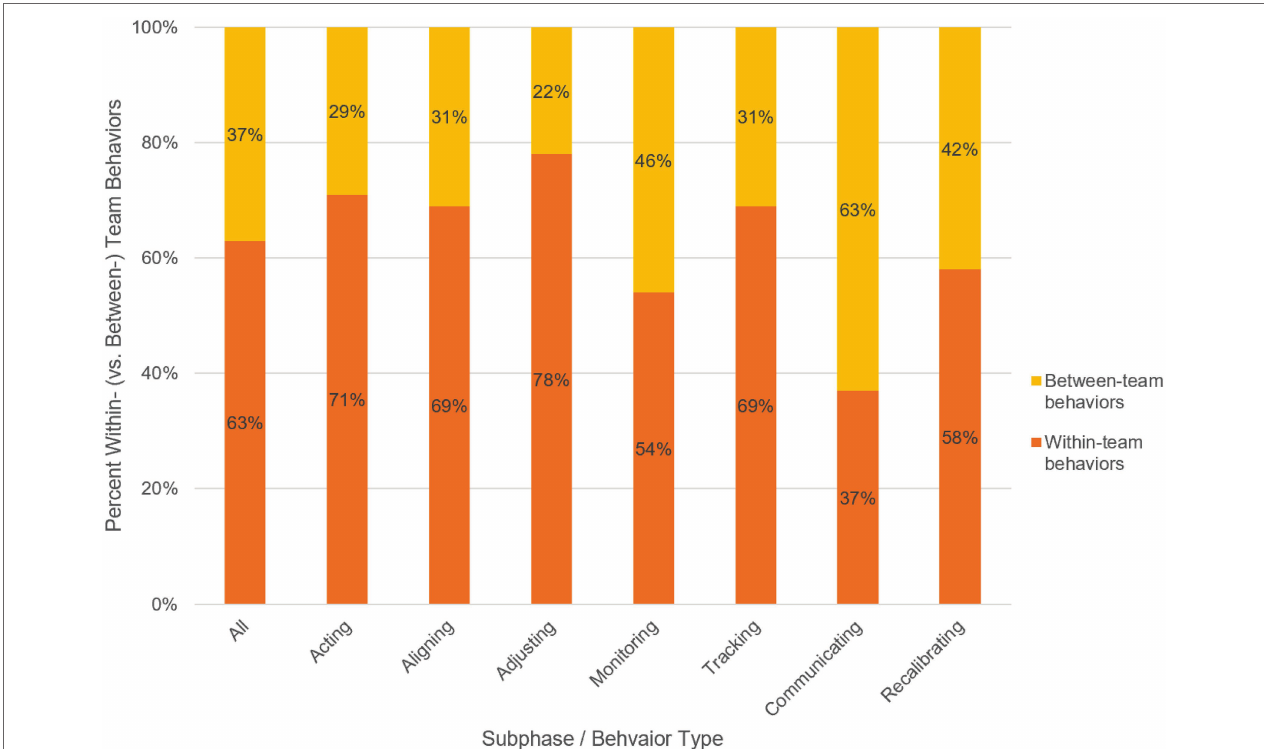
FIGURE 1 | Percent Within vs. Between Behaviors across All Cases by Subphase and Acting and Monitoring Behavior Types. The y-axis represents the percentage of within-team (orange) vs. between-team (yellow) behaviors represented in each behavior type as indicated in the x-axis. The x-axis includes a column for all of the coded behaviors, as well as each subphase behavior type (i.e., acting, monitoring and recalibrating) and each subtype for acting (i.e., aligning and adjusting) and monitoring (i.e., tracking and communicating). For example, the furthest right column indicates that, of all of the coded recalibrating behaviors, 58% occurred at the within-team level and 42% occurred at the between-team